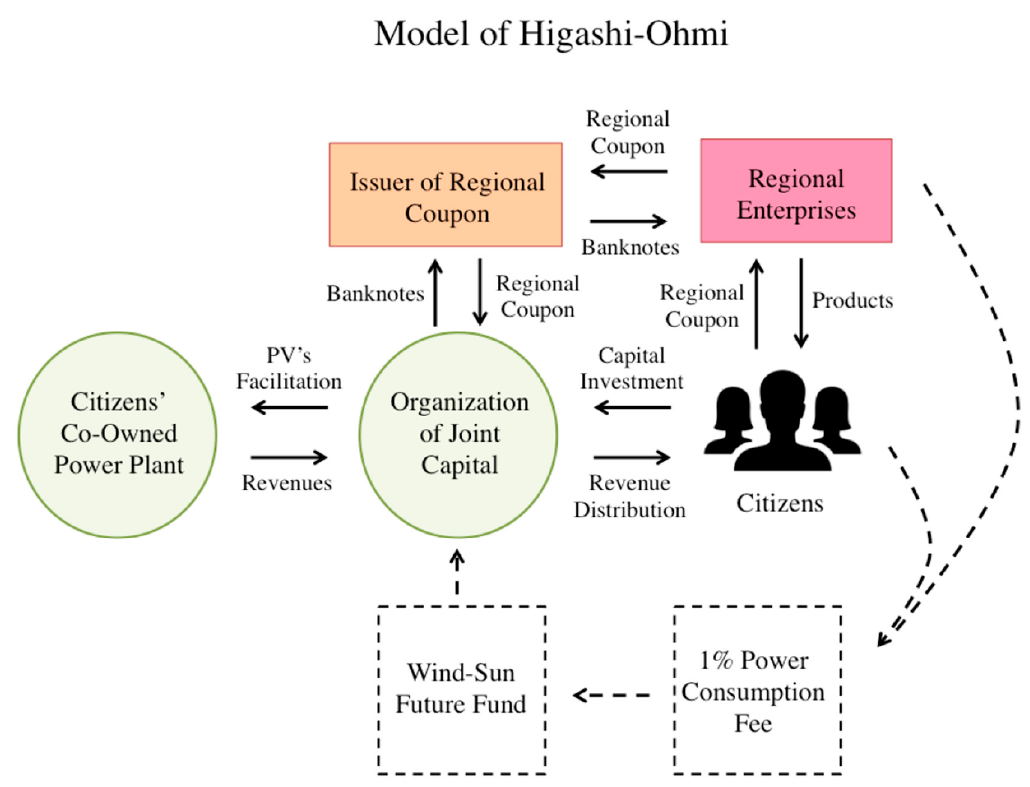
Figure 4. In the Model of Higashi-Ohmi, money circulates within the region through the combination of regional currency and Citizens’ Co-Owned Power Plants. Source: modified from Hashimoto and Nakagawa [51].